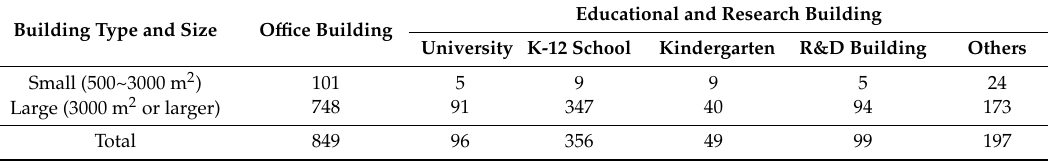
Table 3. Number of certified o ffi ce buildings and educational and research buildings by type and size.